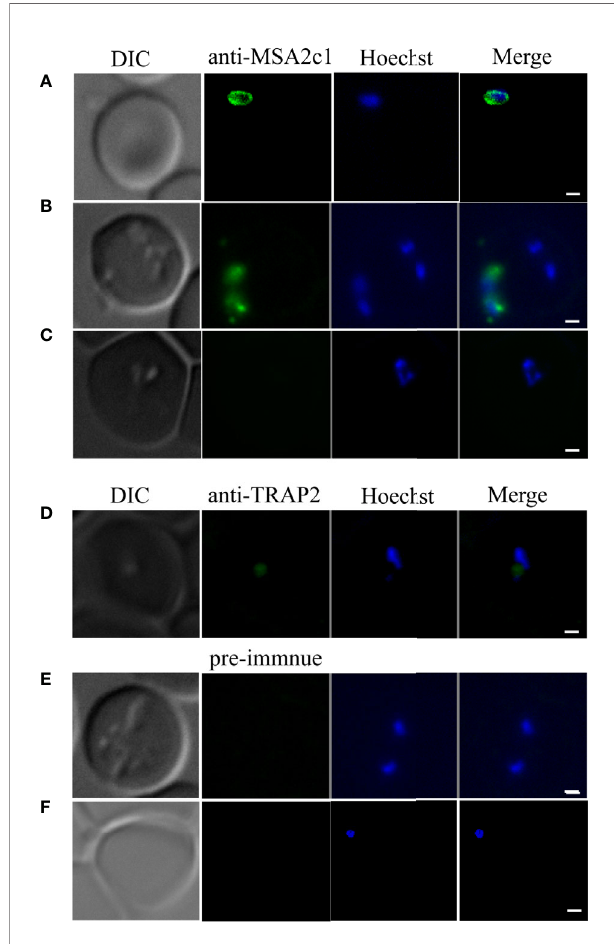
FIGURE 3 | Location of BoMSA-2c1 in B orientalis determined by immuno fl uorescence staining. BoMSA-2c1 is located only on the extracellular parasite membrane. Reactivity of anti-rBoMSA-2c1 serum with parasite during invasion (A) , early-egress (B) , and intracellular (C) stages. Anti-TRAP2 has been used as the positive control for the intracellular parasite (D) , and pre-immune serum has been used as the negative control for validation of intracellular and extracellular parasites (E, F) . PcAb-BoMSA-2c1 and PcAb- BoTRAP2 (blue) exhibited reactions with native proteins on merozoites. Nuclei are indicated in blue with Hoechst counterstain. Scale bars: 1 m